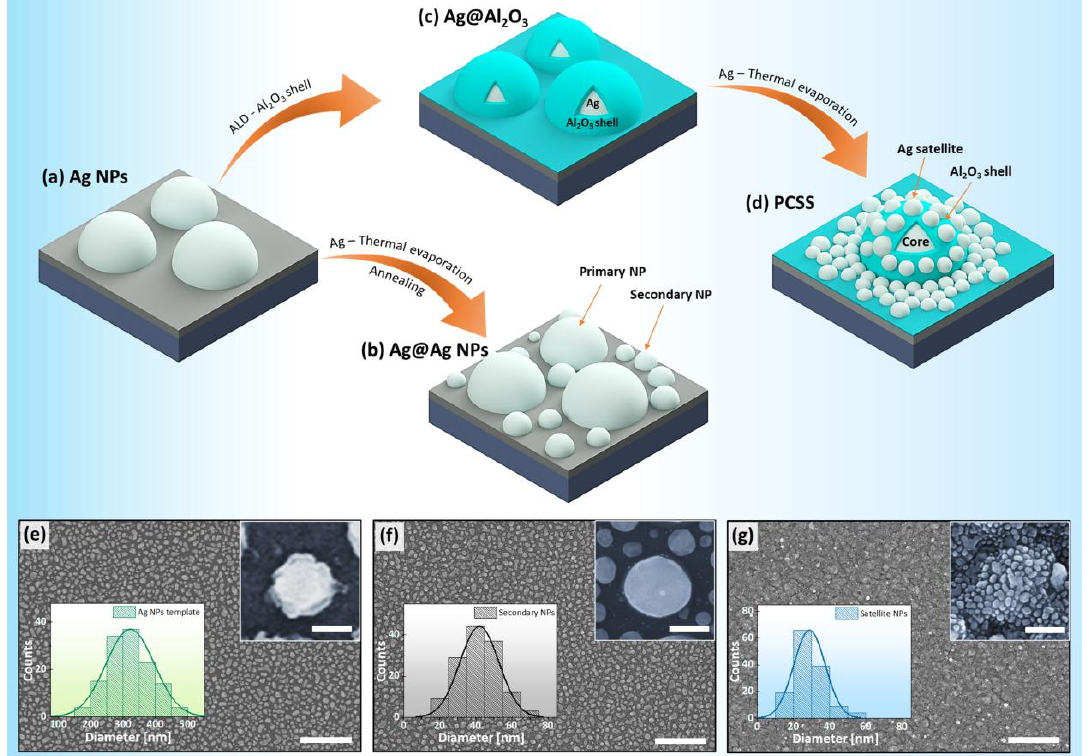
Figure 1. Fabrication procedure for Ag@Ag NPs and plasmonic core-shell-satellite (Ag@Al 2 O 3 @Ag) nanostructures. ( a ) Formation of self-assembled Ag NP template via solid-state dewetting. ( b ) Further coating of the Ag NPs template with thin Ag films followed by low-temperature annealing leading to the formation of Ag@Ag NPs. ( c ) Atomic layer deposition (ALD) of the 3 nm Al 2 O 3 film on the surface of as-prepared Ag NPs arrays. ( d ) Thermal evaporation of 5 nm Ag thin film on the Ag@Al 2 O 3 core–shell nanostructures to prepare plasmonic core–shell–satellite (PCSS) nanostructures. ( e – g ) SEM images of Ag NP template, Ag@Ag NPs, and PCSS nanostructures. Scale bar: 2 µ m. (Insets) Corresponding size distribution histogram and enlarged SEM images of Ag NPs template, secondary Ag NPs, and Ag satellite as labelled. The scale bars in the insets are ( e ) 100 nm, ( f ) 100 nm and ( g ) 130